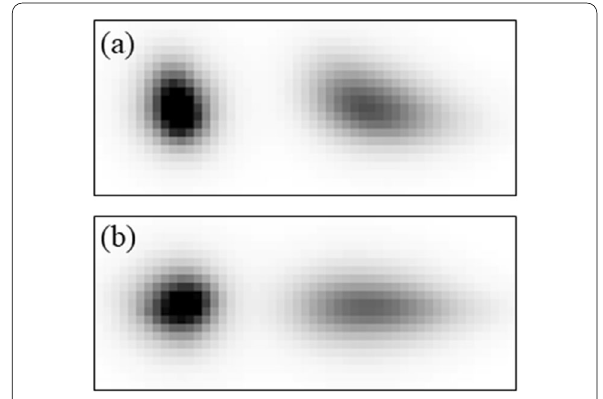
Fig. 10 Zero-order (left) and spectral (right) images of β Cet (Diphda, 2nd in V-magnitude) observed by our spectral camera and the telescope on Nov. 9, 2017. One hundred frames were averaged, and the grayscale is inverted. We flipped the frames horizontally to show the spectral image right side of the zero-order image. The star was around a meridian transit at 54° in zenith angle. a The zenith is up in the image, corresponding to Fig. 9b. b We rotated the camera, and the zenith is the left-hand side, corresponding to Fig. 9c